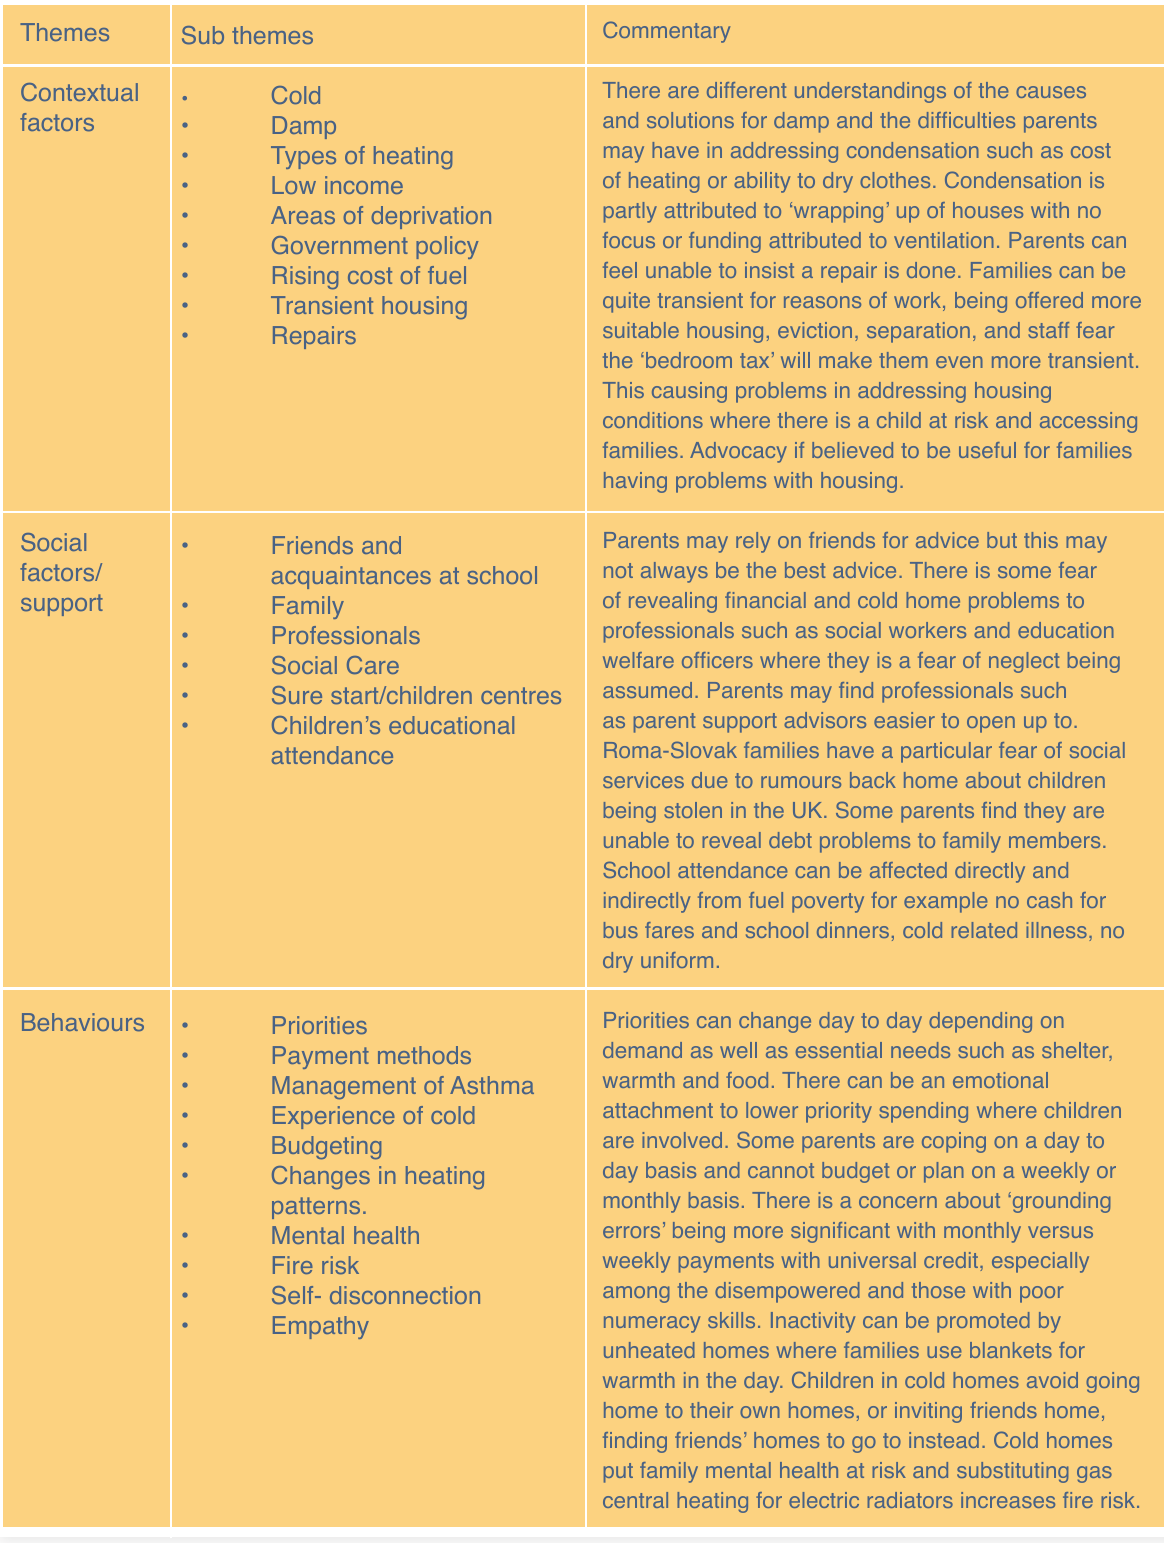
Table 6. Findings from Staff Focus Groups & Interviews